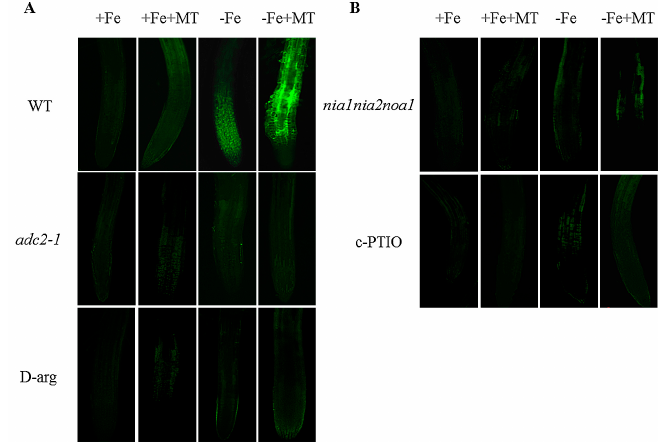
Figure 5. The effect of melatonin on the NO accumulation in roots of polyamine- and NO-deficient Arabidopsis plants. Seven-day-old seedlings were treated with or without 5 μ M melatonin in the presence or absence of 50 μ M Fe for 8 days. Then, NO-associated fluorescence was detected in the roots of polyamine-deficient ( adc2-1 and D -arg-treated) ( A ) and NO-deficient ( nia1nia2noa1 and c-PTIO-treated) plants ( B ).